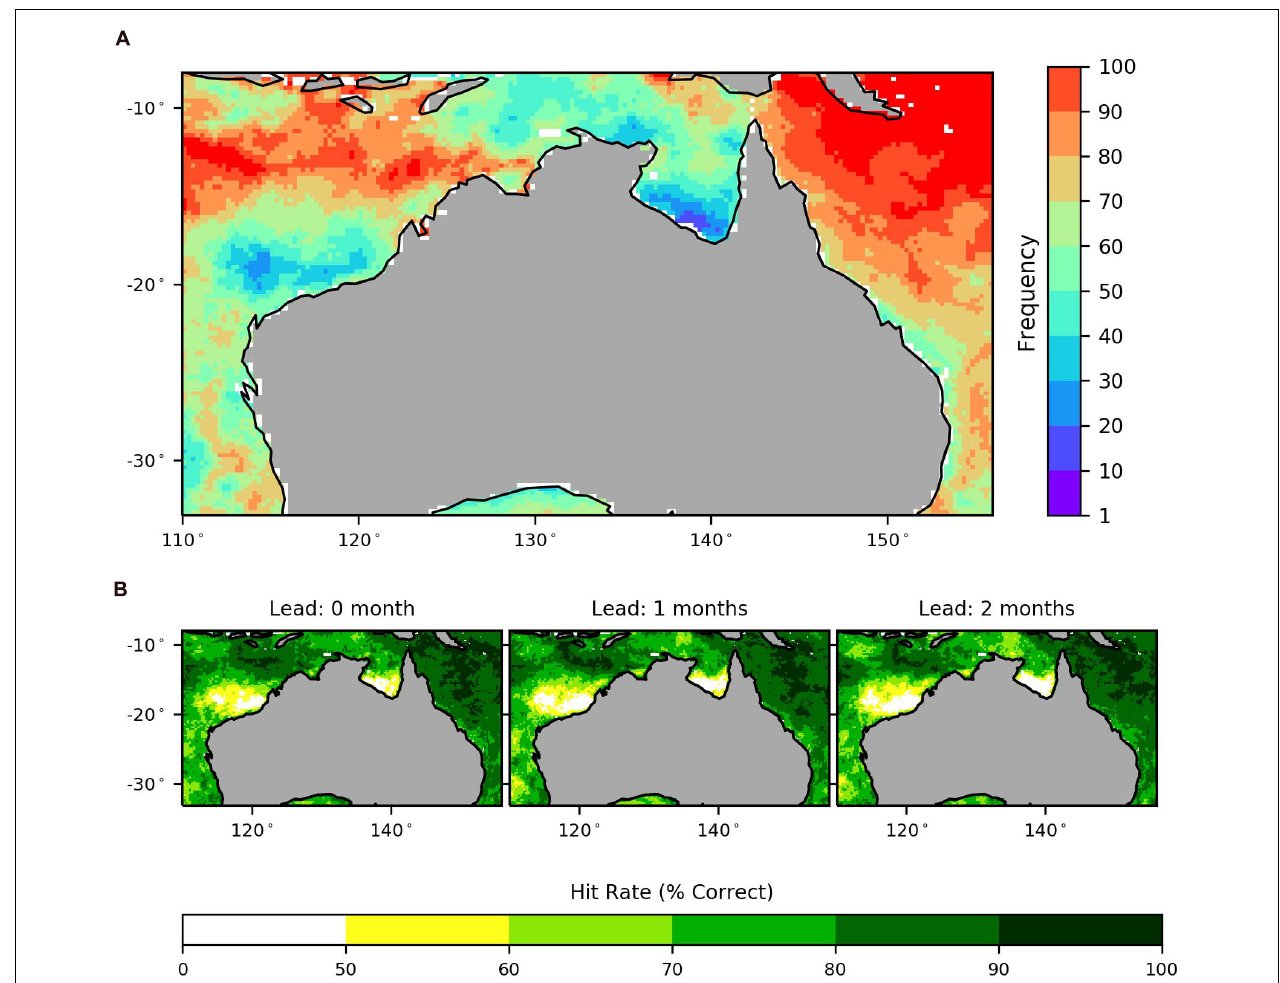
FIGURE 3 | (A) Observed frequency of DHM > 0 events for November to April 1990–2012, together with (B) model hit rates for DHM > 0 for the same period for lead times 0–2 months (total number of months = 138). Note that an event is considered to have been forecast if more than 50% of ensembles have indicated DHM > 0 at a